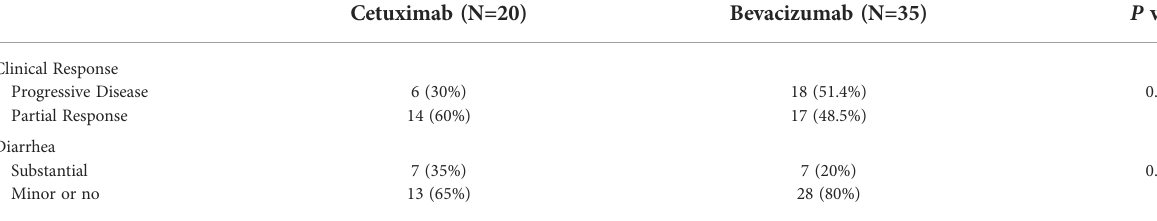
TABLE 2 Results for patients by clinical response and diarrhea